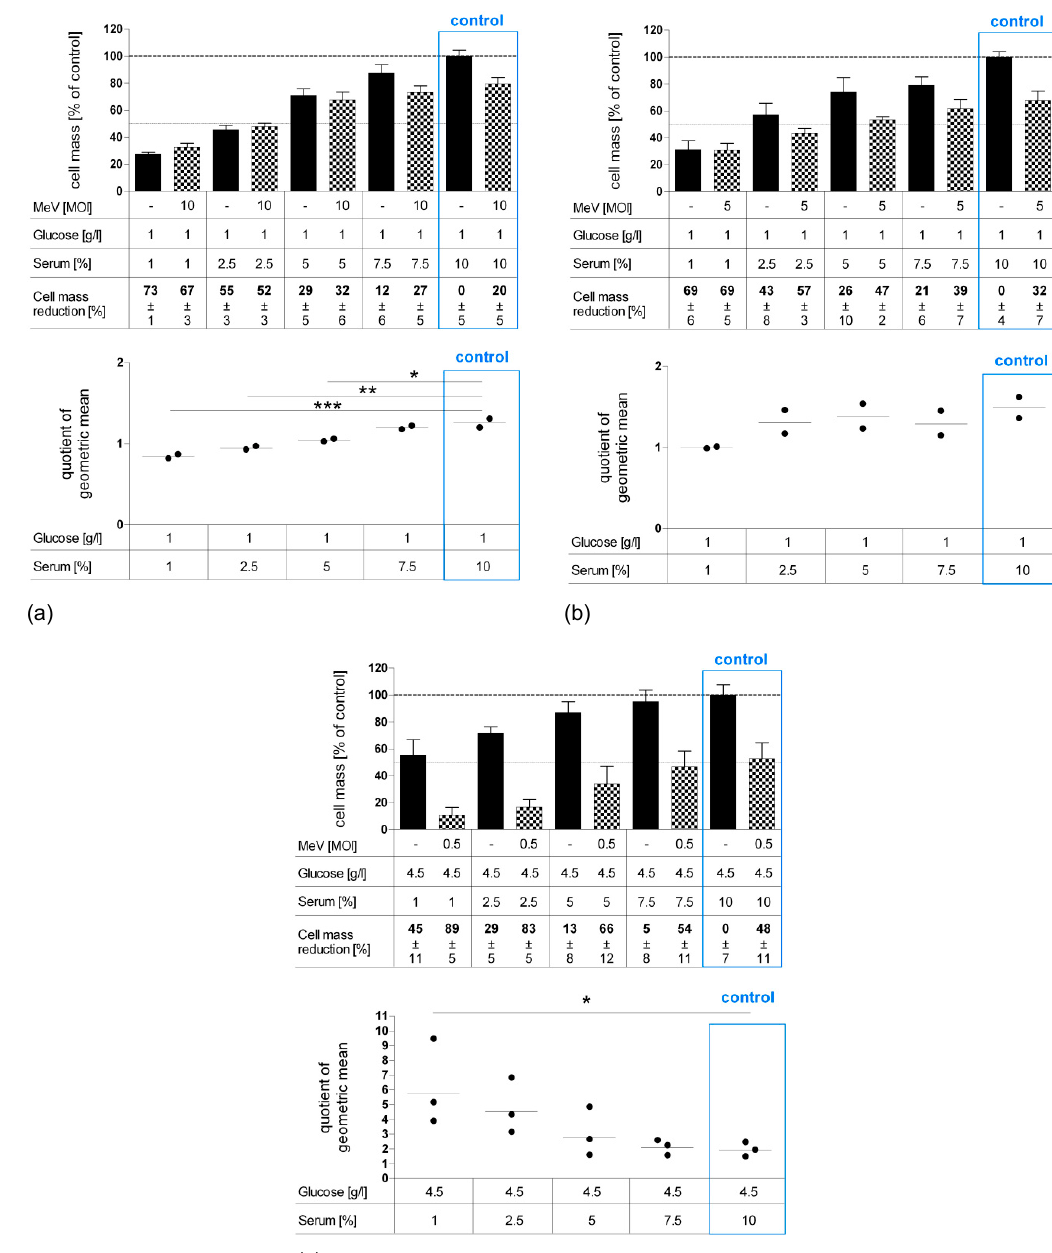
Figure 6. Effect of long-term standard glucose, low-serum starvation on MeV-mediated oncolysis in normal human colon fibroblast cell line CCD-18 Co ( a ) and epithelial cell line CCD-841 CoN ( b ) compared to neoplastic cell line HT-29 ( c ) as determined by SRB assay. Long-term starvation and MeV infection of HT-29, CCD-18, and CCD-841 cells were performed according to Figure 1b. Starvation medium contained standard glucose, but low serum. Note, standard medium in normal colon cells contained only 1 g Glc/L, whereas standard medium in neoplastic cell lines contained 4.5 g Glc/L. For non-malignant cell lines, much higher MOIs were used (MOI 10 and 5) compared to the malignant cell line (MOI 0.5). At 96 hpi, the remaining tumor cell masses were determined by SRB assay. Differences were considered significant when P -values were <0.05 (*), <0.01 (**), and <0.0001 (***).